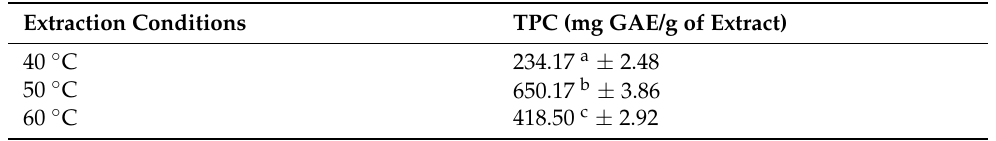
Table 1. Total phenolic content of Lamium album flower for extracts obtained at different variants of